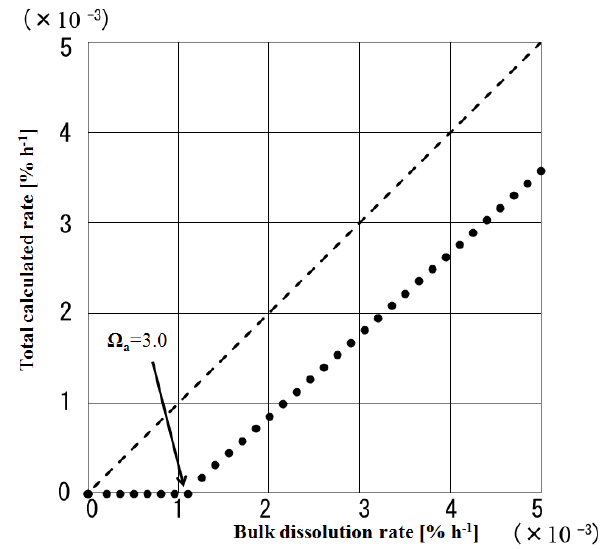
Fig. 8. Relationship between bulk dissolution rate and total calcu- lated dissolution